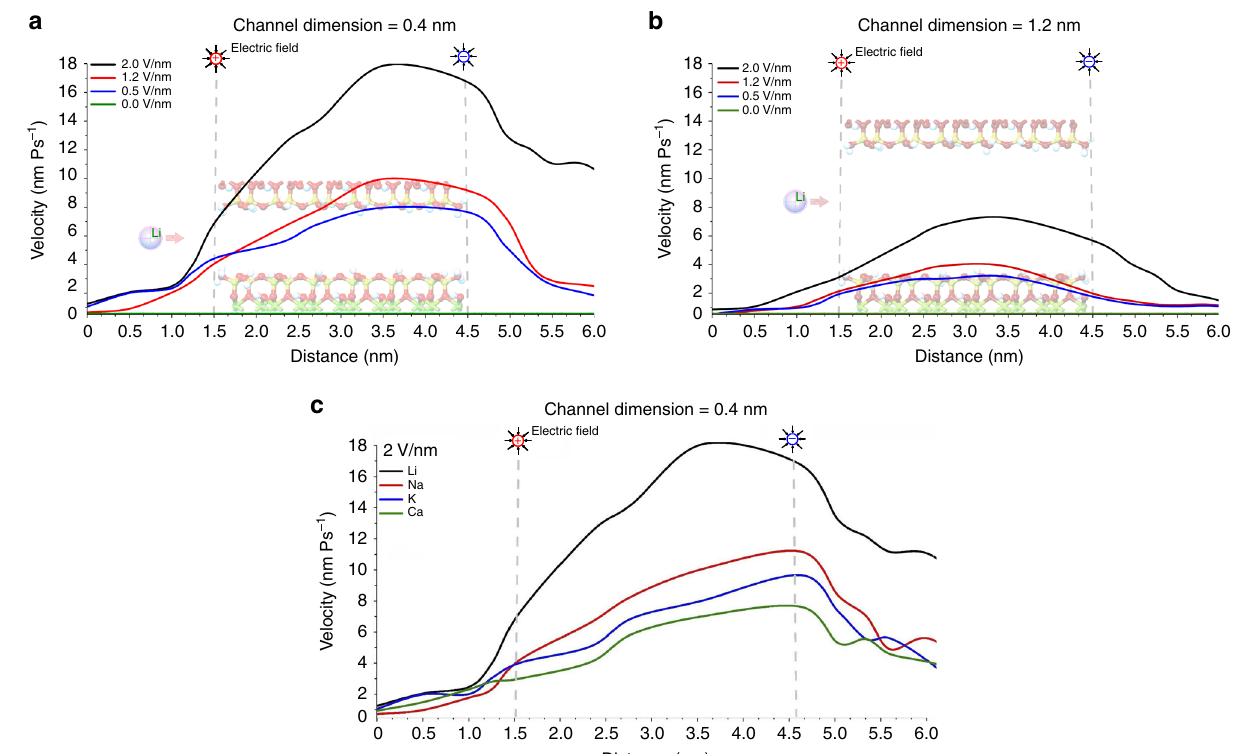
Fig. 8 Effect of driving force on Li-ion selectivity and transport behavior. Effect of the power density of electrical fi eld on the velocity of Li + ions inside a 0.4 nm ( a ) and 1.2 nm ( b ) vermiculite nanochannel. Underlying nanochannels representations in a , b are 3 nm (length) vermiculite nanochannels. The